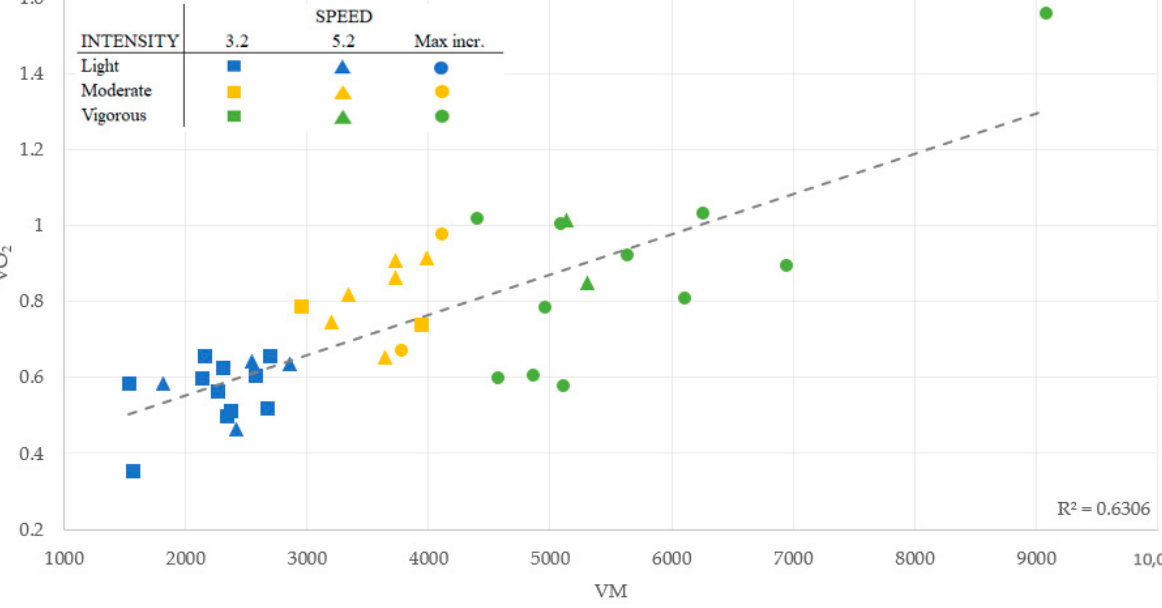
Figure 2. Linear Regression Model: Vector Magnitude association with the Relative Oxygen Consumption (VO 2 ).